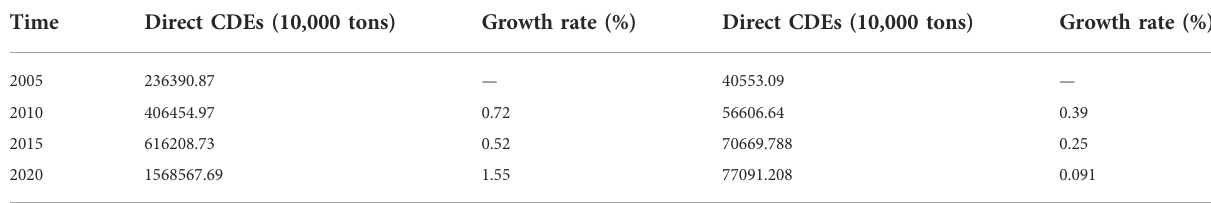
TABLE 3 Direct CDEs and growth rate of the power industry.